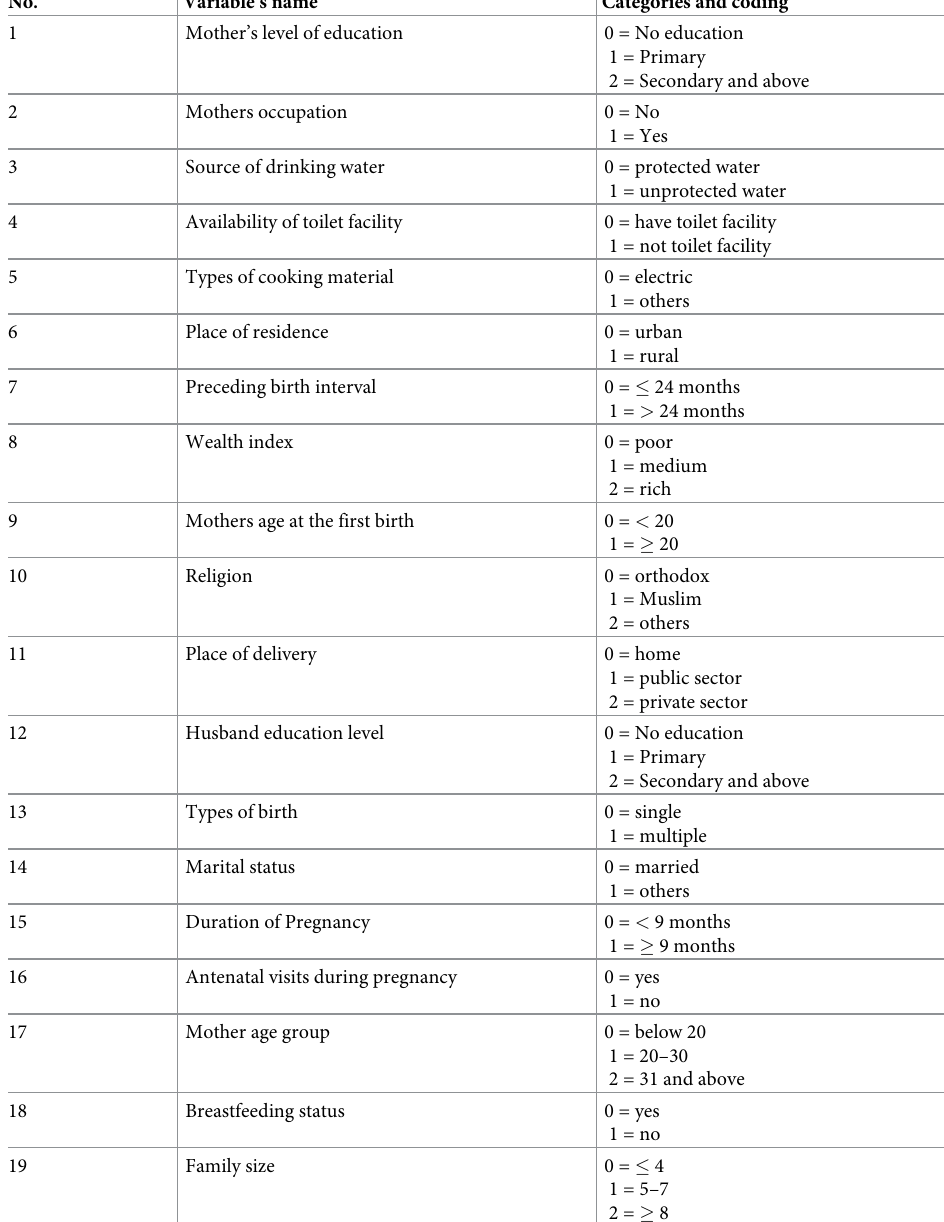
Table 1. Coding and categories of all explanatory